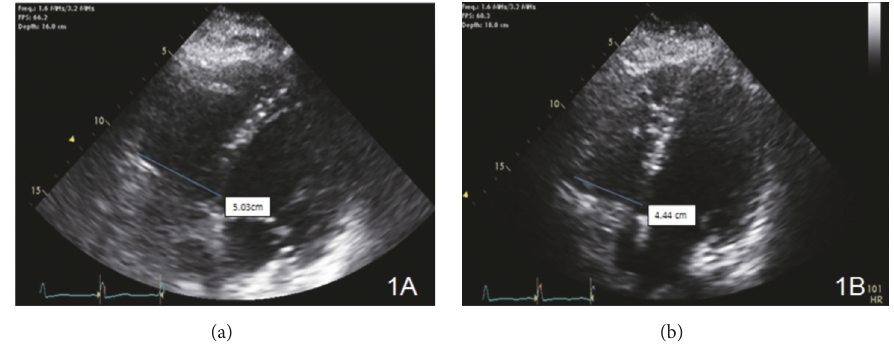
Figure 1: (a) Right ventricular size and function assessment was done with RV focused imaging from apical four chamber view. Initial measurement showed 5.03 cm RV basal diameter consistent with moderately dilated RV size. 2D images also showed reduced RV ejection fraction along with RV strain findings. (b) Right ventricular size and function assessment was done with RV focused imaging from apical four chamber view. RV basal diameter is measured as 4.44 cm which was consistent with mildly dilated RV size. RV ejection fraction is improved, and RV strain findings were no longer available.